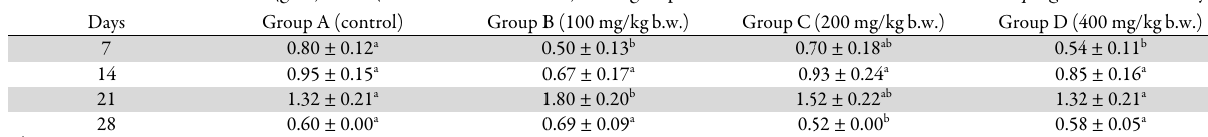
Table 8. Mean serum creatinine (g/dl) levels (means ± standard error) of rat groups administered methanol fruit extract of Days